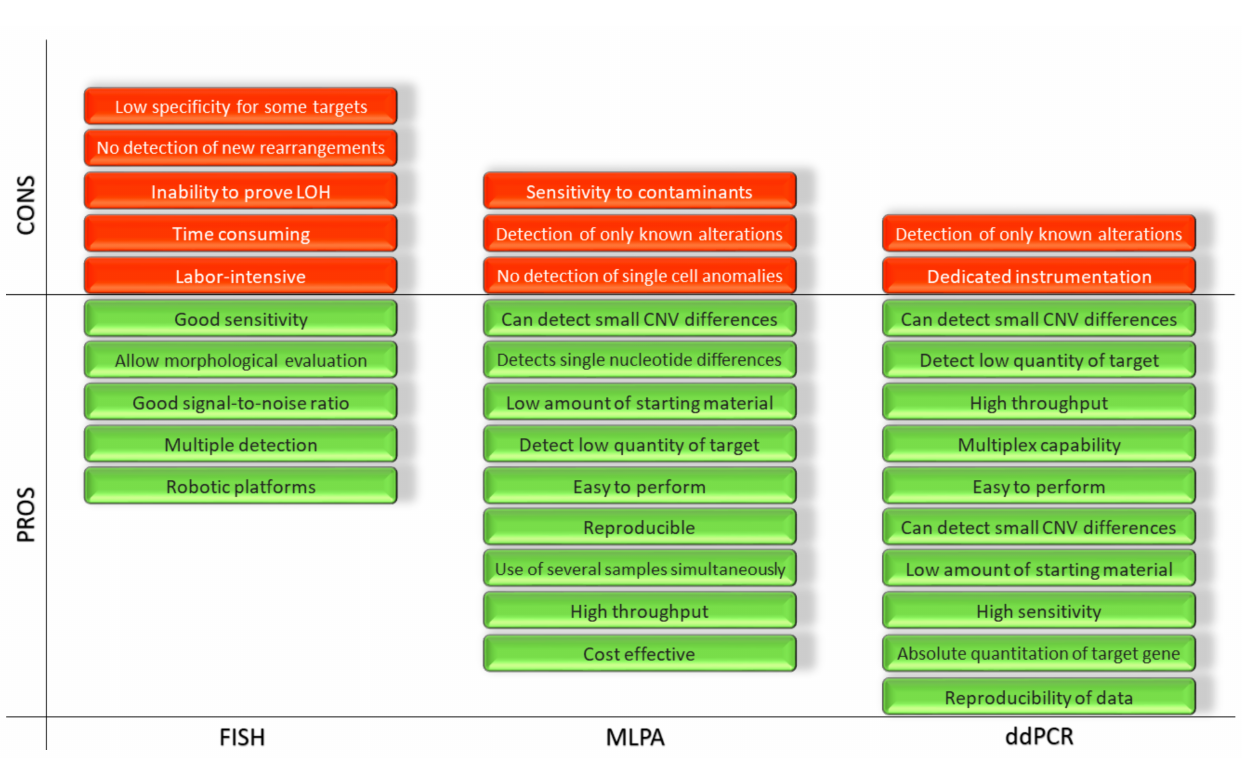
Figure 4. Representation of the advantages and disadvantages of the FISH, MLPA and